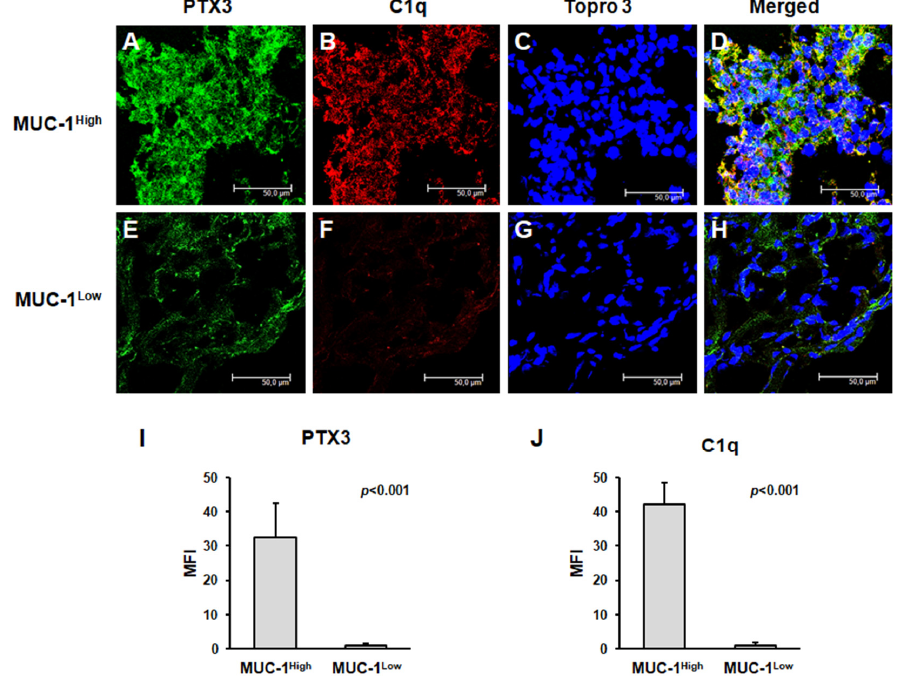
Figure 2. PTX3 protein expression and colocalization with C1q in neoplastic renal tissues from MUC1 H ccRCC ( A – D ) and MUC1 L ccRCC ( E – H ) by confocal microscopy and quantification of specific fluorescence ( I , J ).